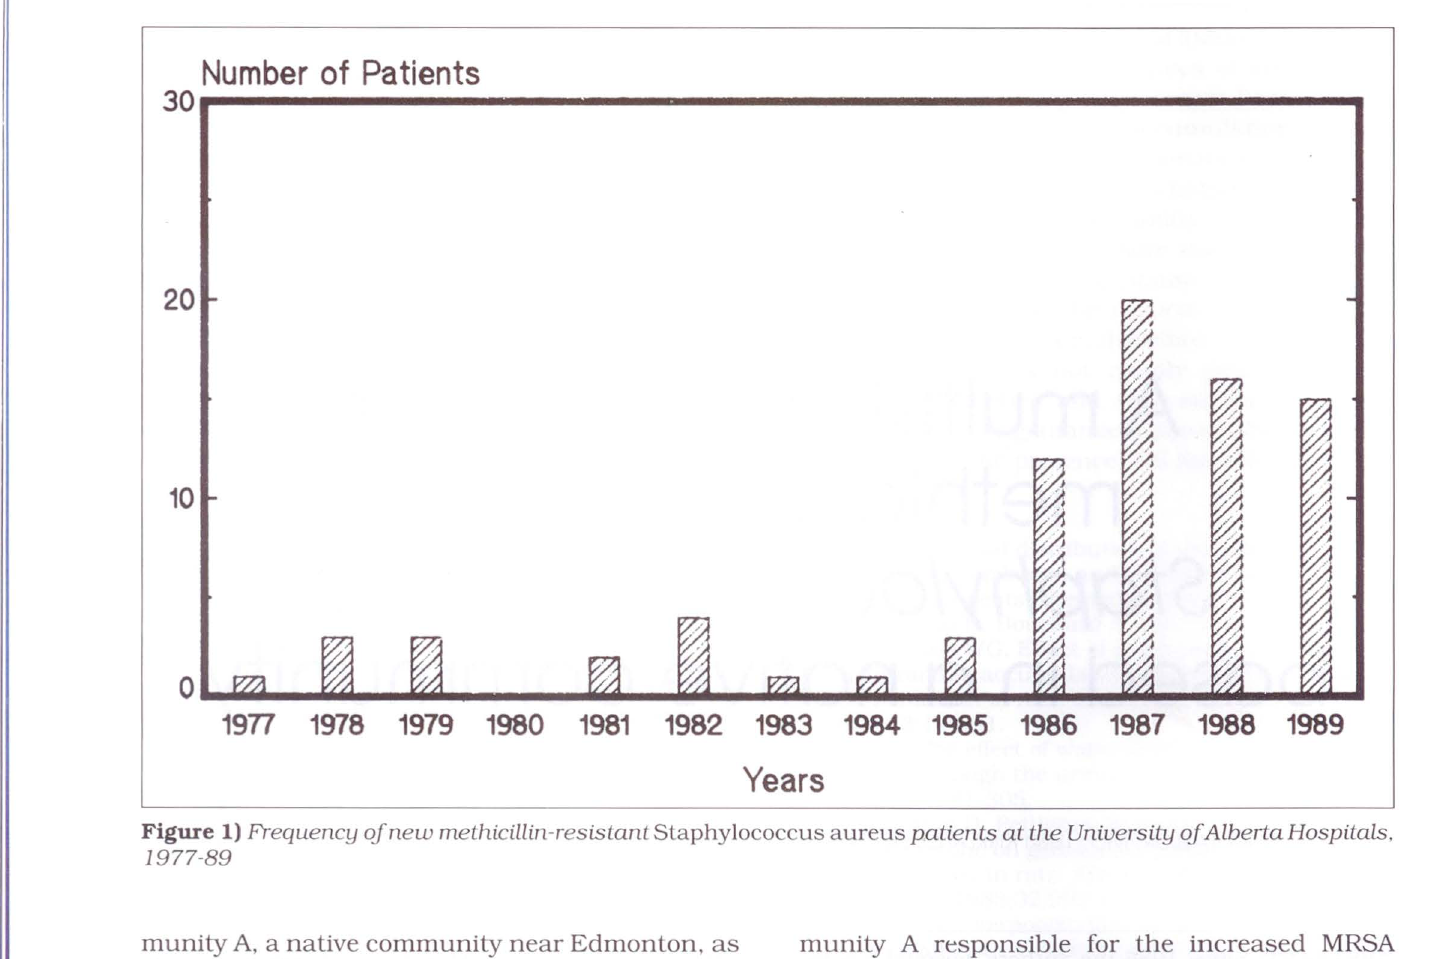
munity A, a native community near Edmonton, as the source